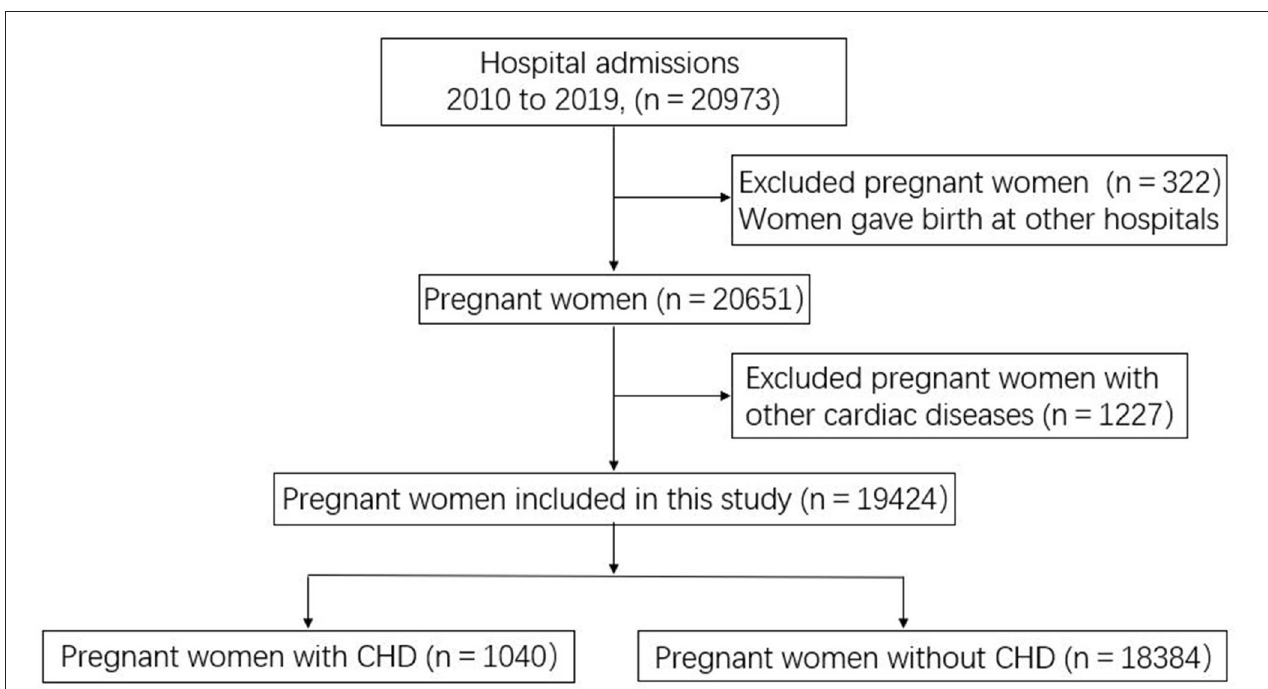
FIGURE 1 | Flowchart of data collection for pregnant women with and without